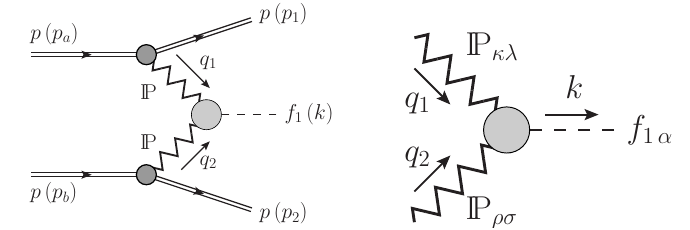
Figure 1: Diagrams for the reaction (1) with double- (cid:80) exchange and the (cid:80)(cid:80) f The pomeron ( (cid:80) ) is essential object for understanding diffractive phenomena. Within QCD is a color singlet, predominantly gluonic object, thus the CEP of mesons has long been regarded as a potential source of